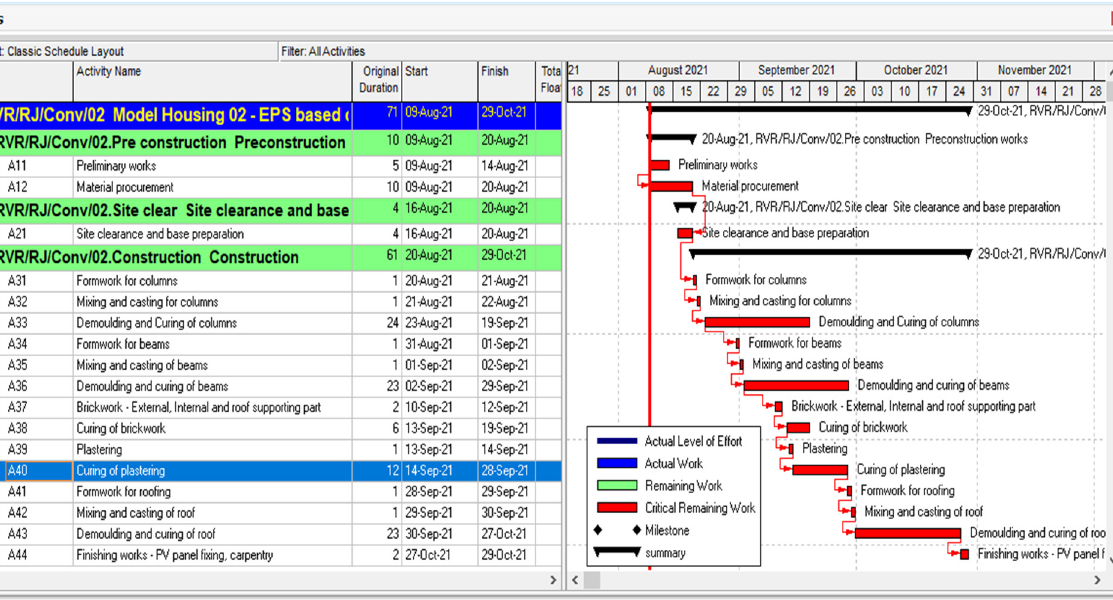
Figure 17. Schedule of Case A—complete conventional construction.